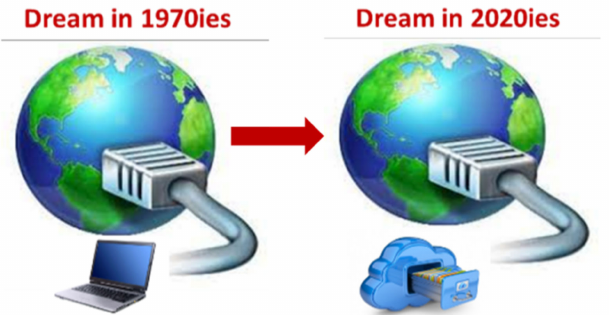
Figure 1. This figure indicates the dreams related to new paradigms. While the dreams in the 1970s of an easy plug-in of any compliant device into the Internet became reality after many years, the dream of a unified data space supporting an easy plug-in of data entities needs to be